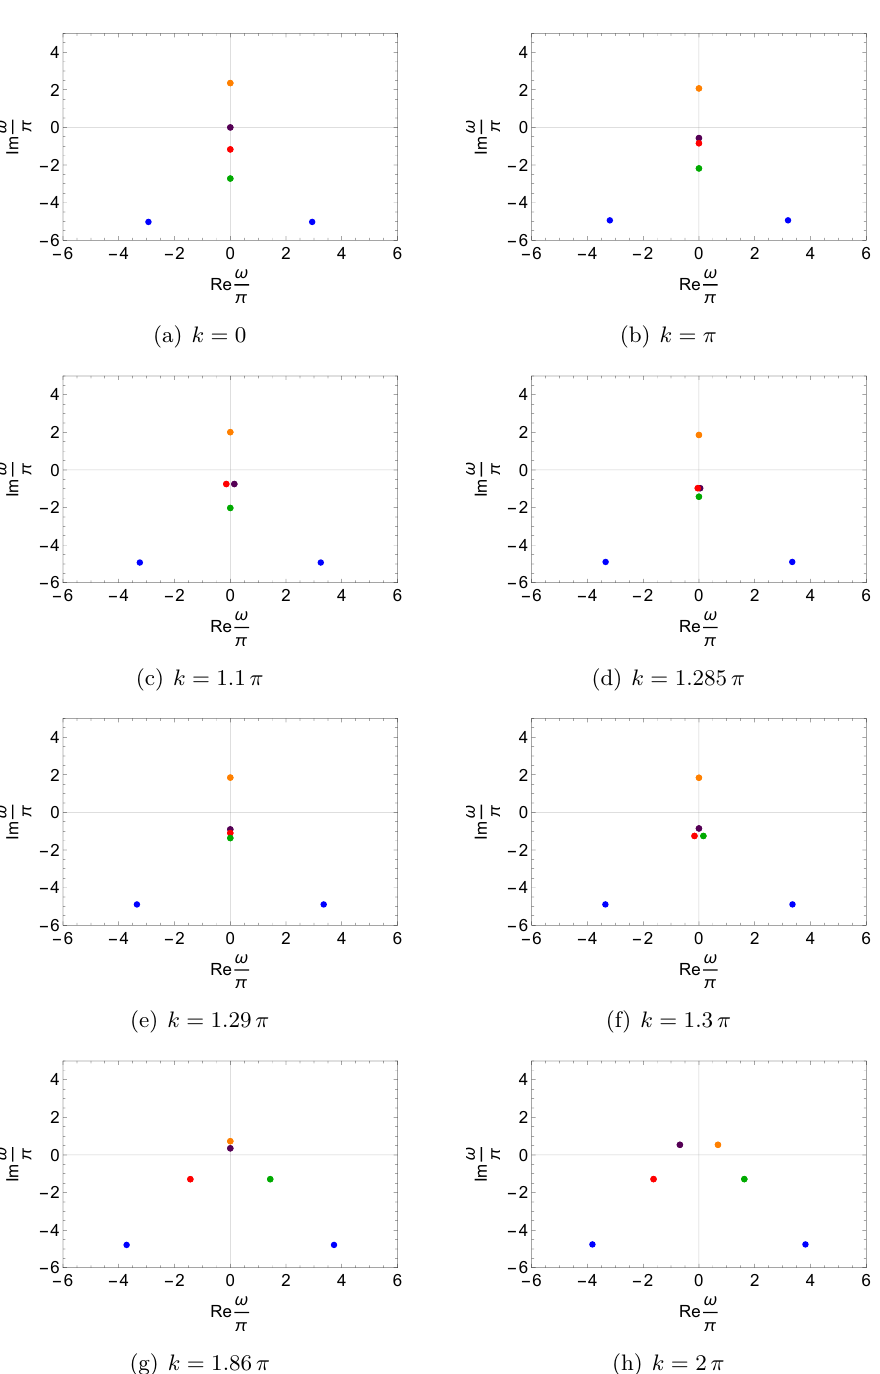
Figure 5 . Behavior of the first six QNMs in complex frequency plane with varying k at ˆ β = 0 . 391 . Unlike the case of ˆ β = 0 . 35 in figure 3, the diffusion pole (shown in purple) and the quasi-hydro mode (shown in red) do not move permanently away from the imaginary axis after collision. They return back to collide again on the negative real axis, after which one of them moves down colliding with the upward moving ω G (shown in green) and producing a pair of horizontally moving stable quasinormal modes. The other one moves upwards and crosses the origin, etc., as in the case of β = 0 . 35